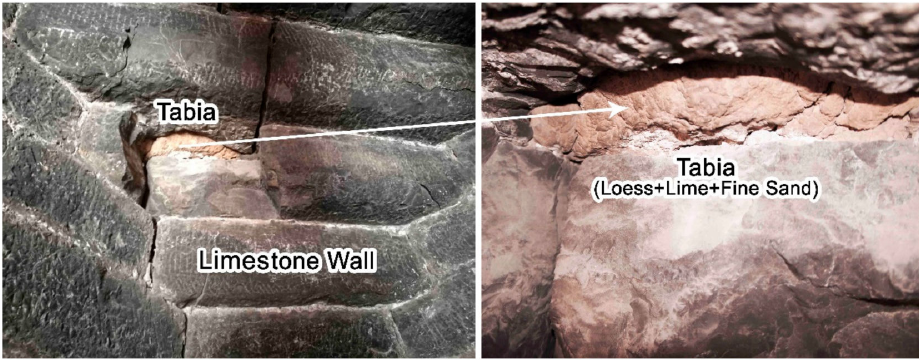
Figure 4. Tabialayer exposed from internal stone damage of the Limestone